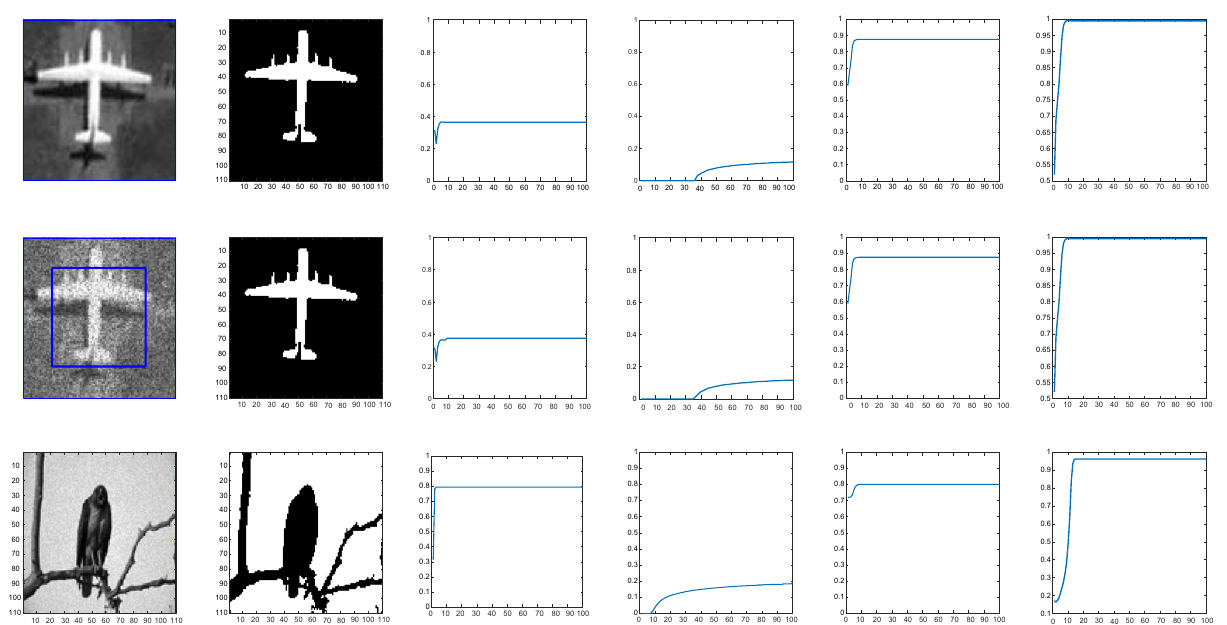
Figure 13. First row is a clear image, second row is noisy image, and third row is noisy and is taken from the Berkeley’s data set. The second column shows the clean image. The Jaccard similarity coefficient for Wu et al. 24 , Li et al. 15 , Krinidis et al. 31 and the proposed model with p = 0.5 , µ = 0.7 , and σ = 3 is shown in the third, forth, fifth and sixth column. The x-axis denotes the iterations and y-axis is the Jaccard accuracy in each time step